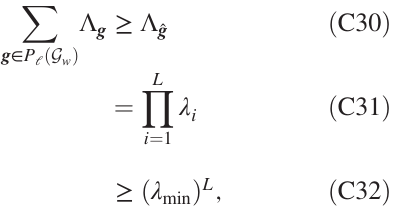
, where the node N α belongs to the middle module graph, while the node ; β β